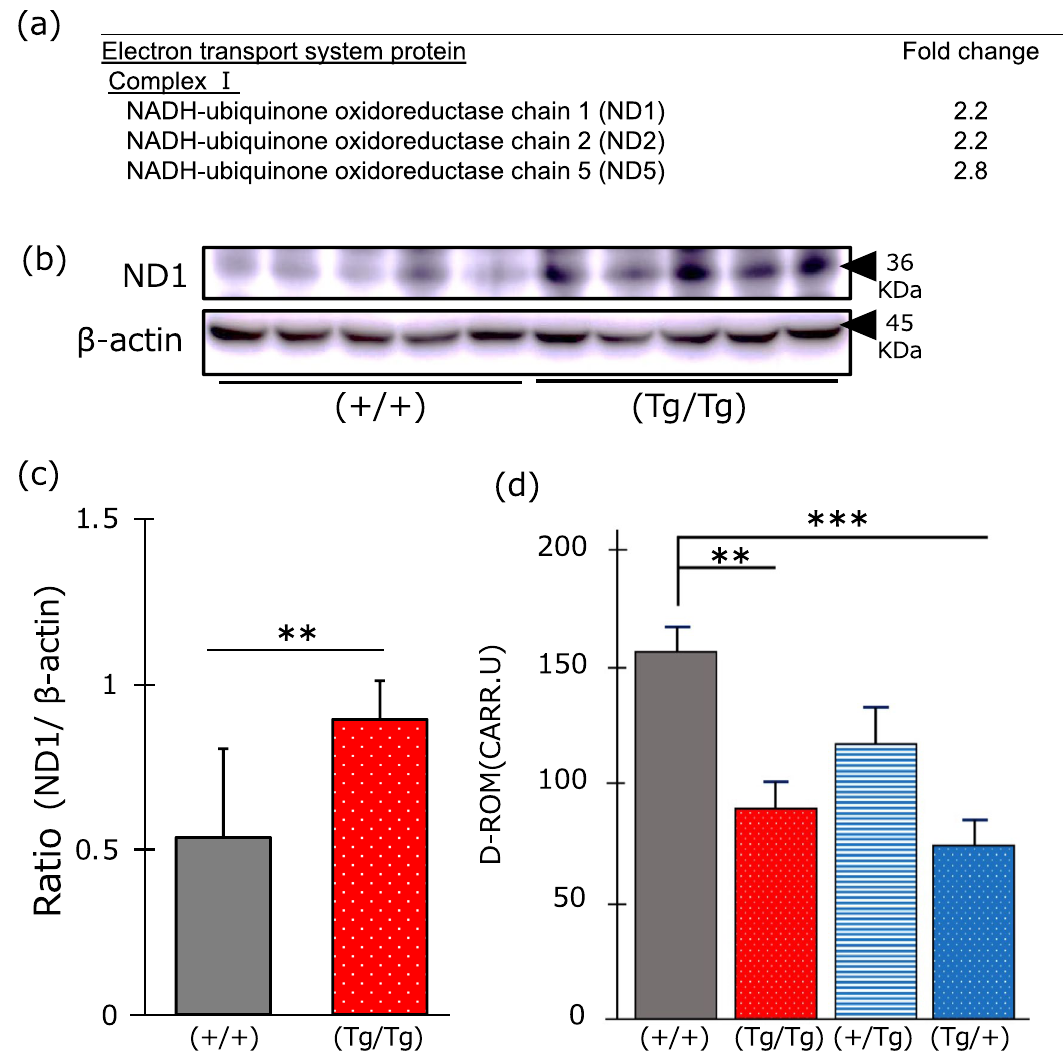
Figure 5. Analysis of mutated ND1 in the mitochondria. ( a ) iTRAQ data of the electron transport system. ( b ) Western blotting for wild-type ND1 and β-actin in (+/+) and (Tg/Tg) fish. This figure was created using Ingenuity Pathway Analysis (IPA) version 2.1, QIAGEN. ( c ) Signal intensities of ND1 proteins measured by ImageJ. Red denotes (Tg/Tg), and gray denotes (+/+). The ND1 signal was divided by that of β-actin. ( d ) Concentration of ROS in (+/+), (Tg/Tg), (+/Tg), and (Tg/+) fish determined by d-ROM analysis. Vertical bars represent standard errors. ** p < 0.01 and *** p < 0.001; Student’s t -test in ( c ) and one-way ANOVA followed